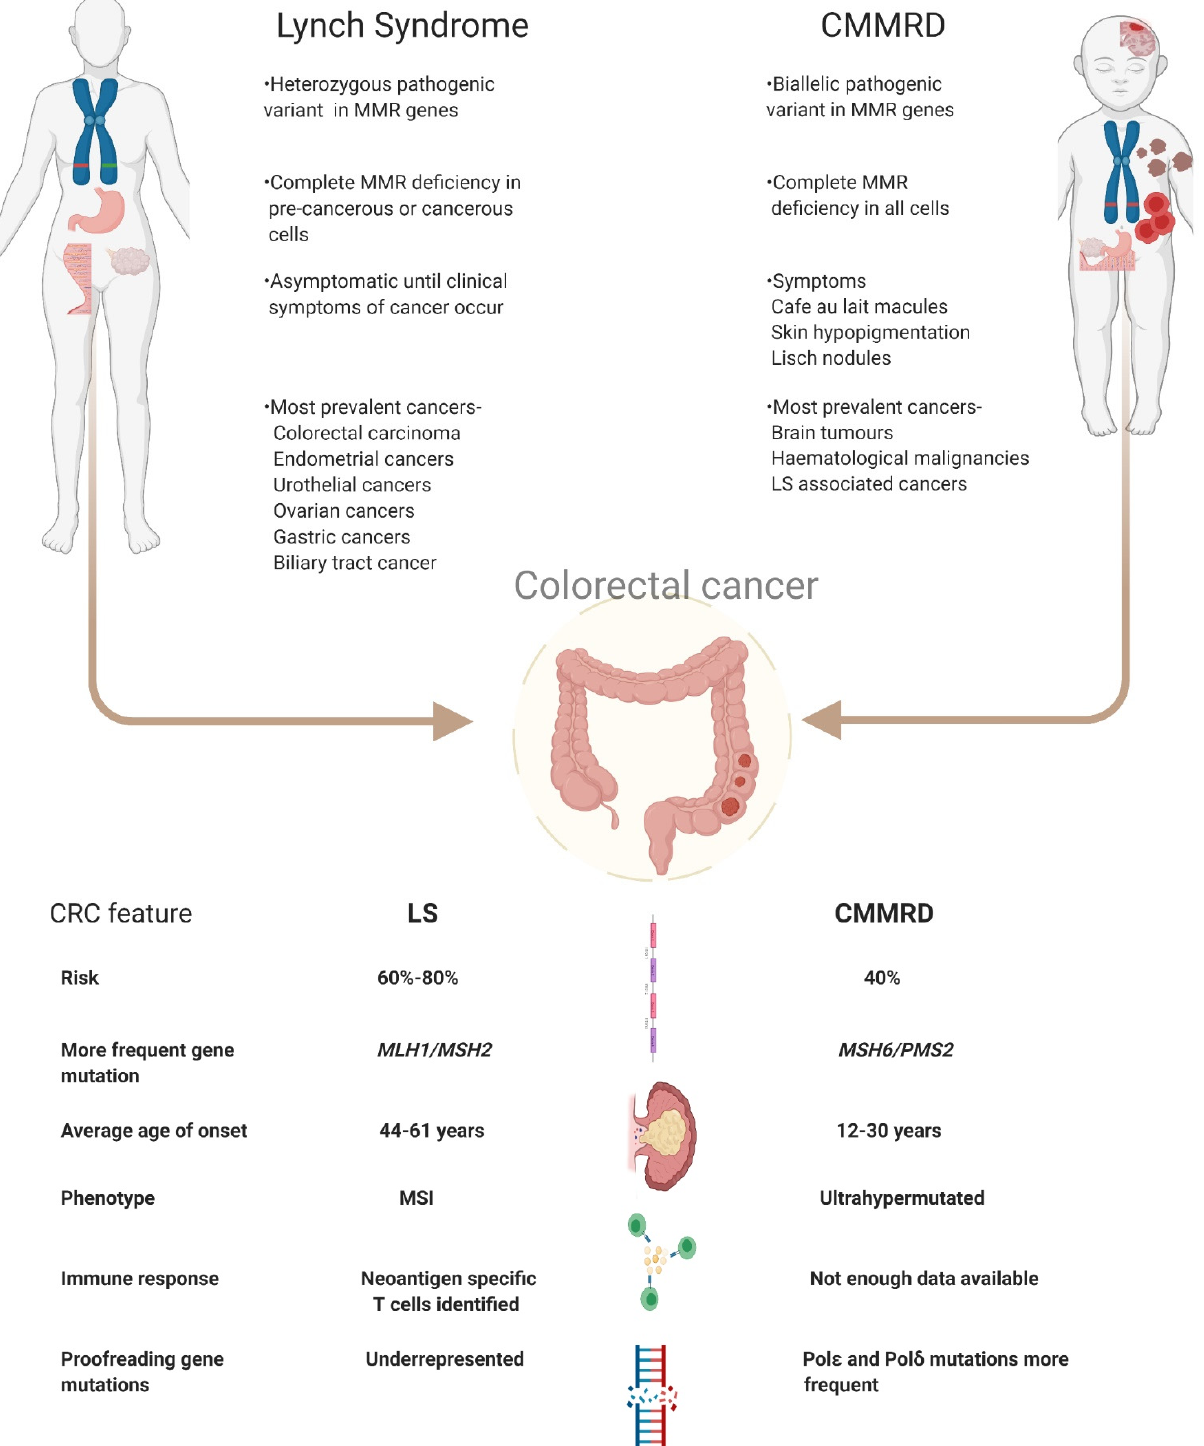
Figure 1. Schematic view on the differences between LS and CMMRD with a focus on colorectal cancer. Abbreviations used- LS: Lynch Syndrome, CMMRD: Constitutional mismatch repair deficiency syndrome, MMR: mismatch repair, CRC: colorectal cancer, MSS: microsatellite stable, MSI: microsatellite instable.